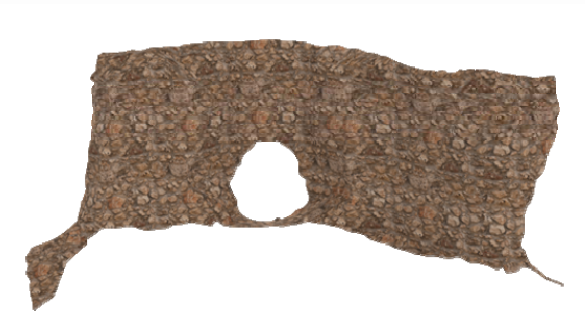
Figure 5 : Rendering with realistic texture